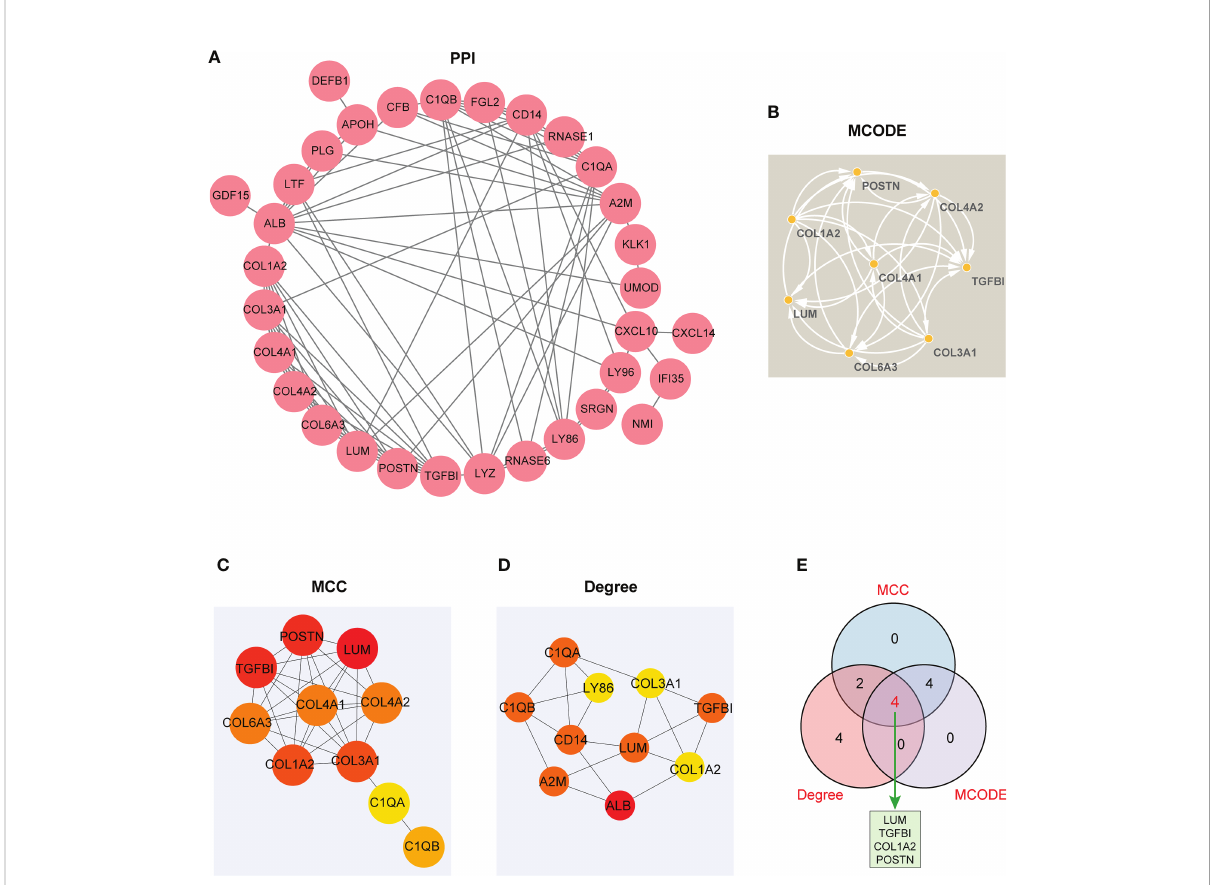
FIGURE 6 The visualized PPI network of EP-DEGs for determining the key EP-DEGs. (A) Construction of the PPI network of 38 EP-DEGs via the STRING database. (B) A total of eight candidate genes were identi fi ed from EP-DEGs according to the score sorted by the MCODE method using Cytoscape. (C) Top 10 genes were obtained according to the score calculated by the MCC method. (D) Top 10 genes were selected according to the score calculated by the Degree method. (E) Venn diagram displaying four key genes such as LUM, TGFBI, COL1A2, and POSTN acquired by the intersection of the three methods (MCC, Degree, and MCODE). The other genes obtained from the intersection between MCC and Degree methods were C1QB and C1QA. The other genes obtained from the intersection between MCC and MCODE methods were COL3A1, COL6A3, COL4A2, and COL4A1.